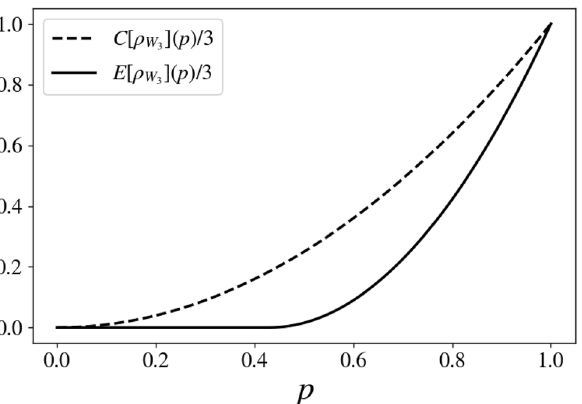
( p )/ 3 (dotted line) and E ρ W Figure 4. C 3 ] [ 1 ) is, as expected, the maximally entangled, and that the states ρ that the state ρ W 3 ( p = separable. The latter are genuinely three-partite entangled